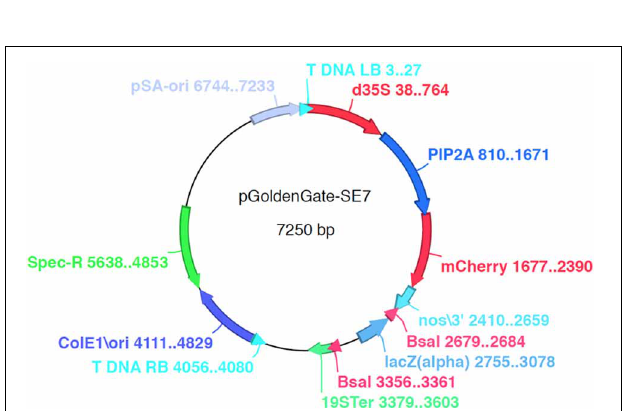
FIGURE 2 | pGoldenGate-SE7